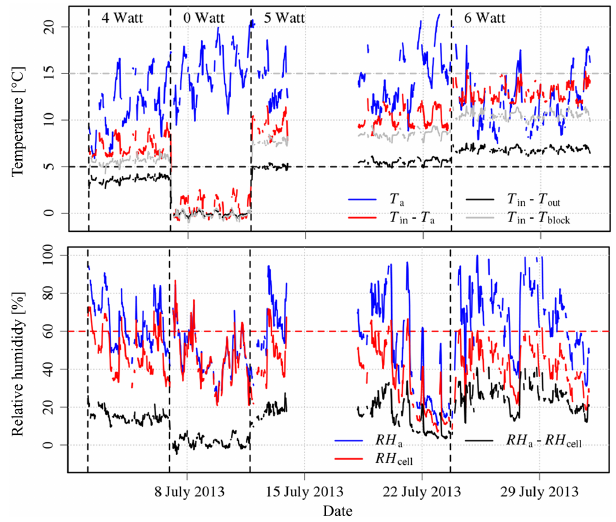
Figure 6. Example time series of the ambient air temperature and relative humidity during field test periods with different heating set- tings of the LI-7200 intake tube and filter, indicated by the dashed vertical lines. Top panel: ambient air temperature ( T a ), LI-7200 cell inlet, outlet and block temperature ( T in , T out , T block , respectively) and differences thereof. The dashed horizontal line indicates a 5 ◦ C threshold for the temperature gradient across the LI-7200 cell. Bot- tom panel: ambient relative humidity (RH a ), in the LI-7200 cell (RH cell ), and differences thereof. The period of missing data in mid- July corresponds to the water ingress which occurred on 14 July